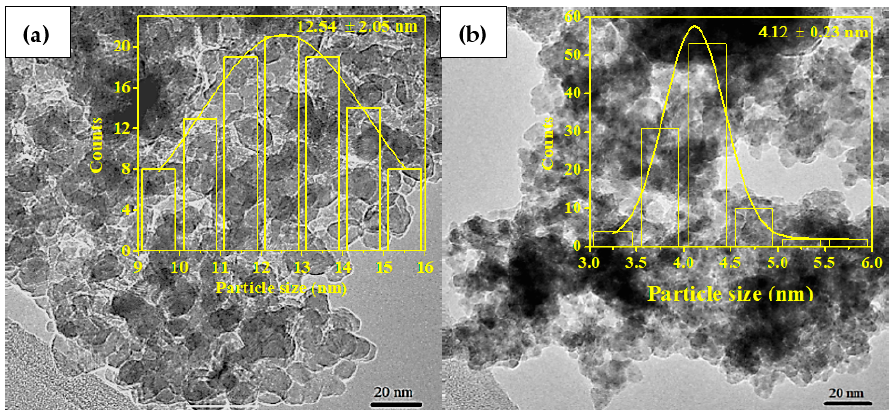
Figure 3. TEM image of ( a ) ZT and ( b ) ZnO QDs. The average particle size is shown in the insert.